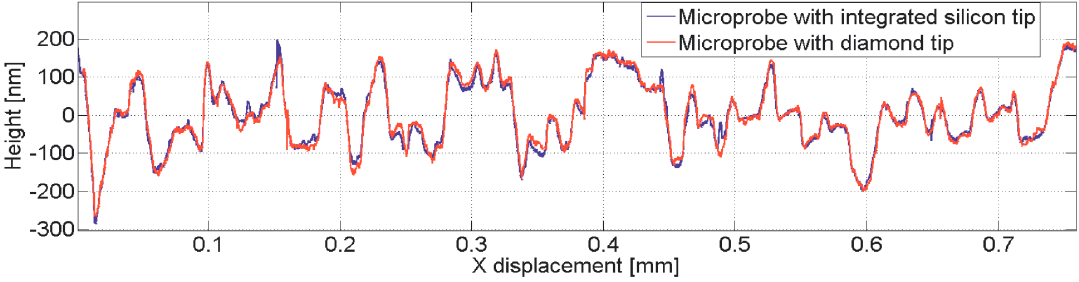
Figure 31. Comparison measurement of a super fine roughness standard between a microprobe with silicon tip and a microprobe with a diamond tip .